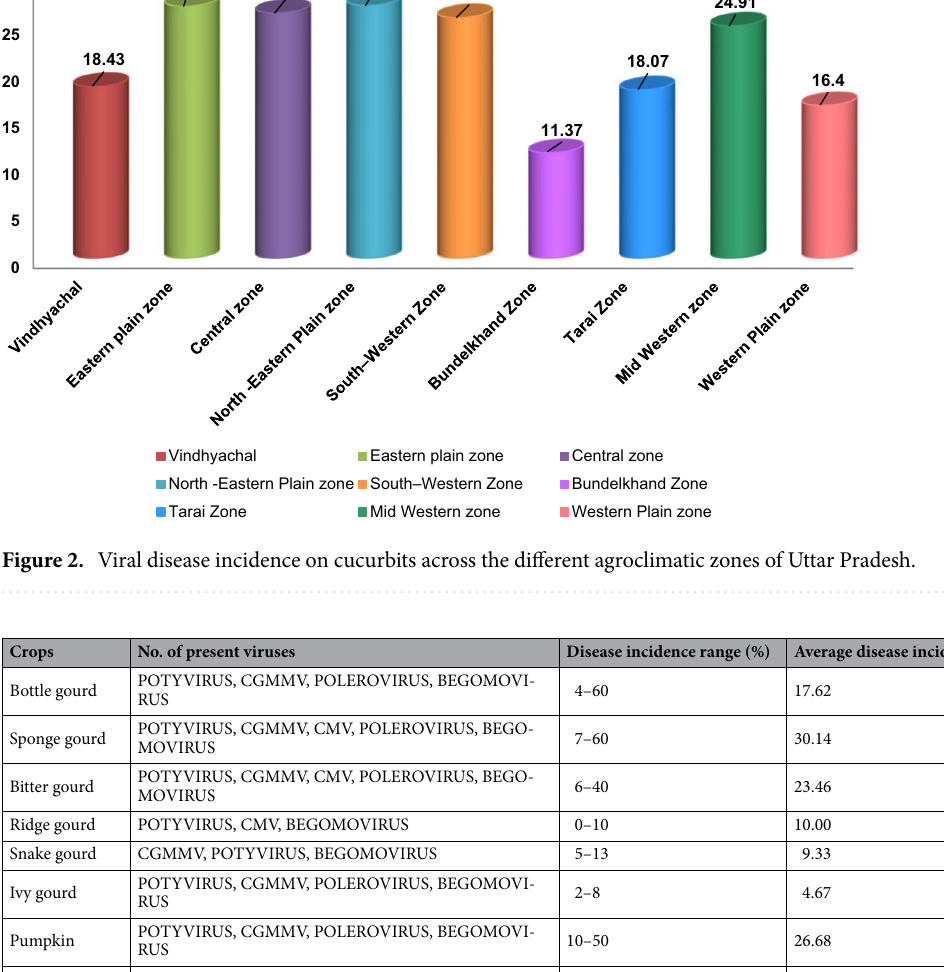
Table 1. Disease incidence of viruses in different cucurbit crops collected across Uttar Pradesh.